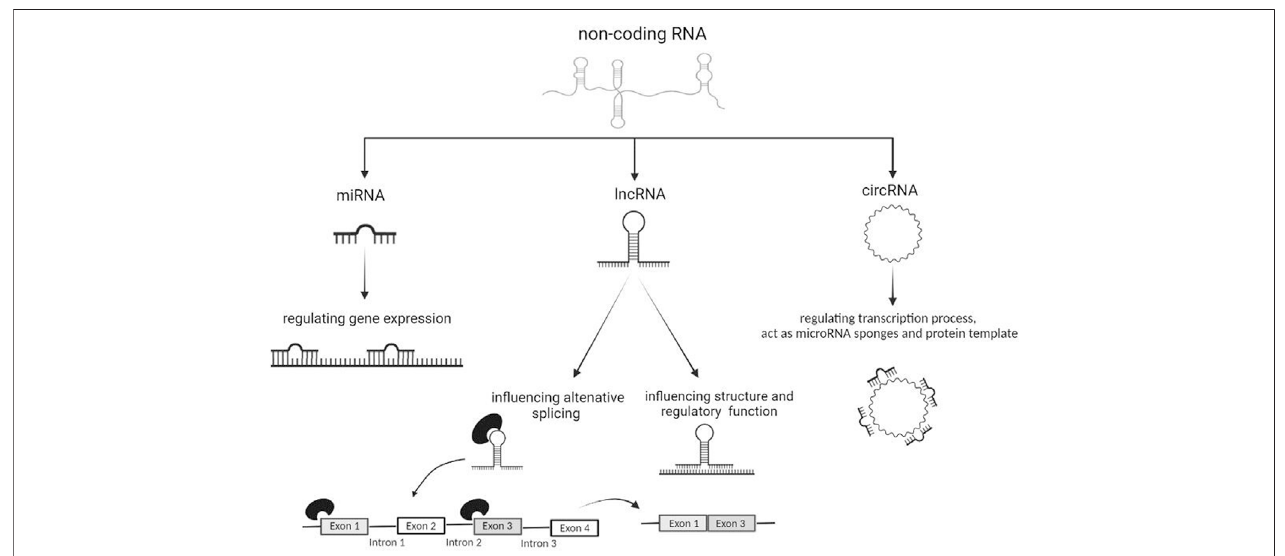
FIGURE 1 | The actions of miRNAs, lncRNAs and circRNAs on different molecular processes.